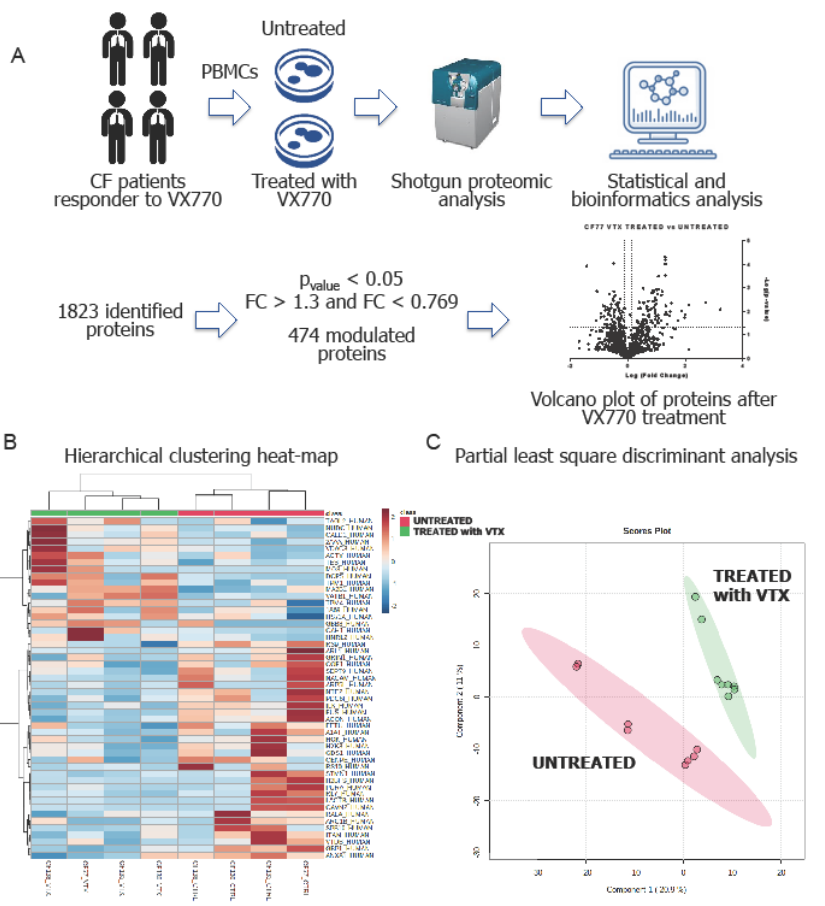
Figure 4. Shotgun proteomics of PBMCs treated with VX770 and untreated. ( A ) Modulated proteins were then elaborated with bioinformatics to identify biological mechanisms associated to CFTR restoration. A representative Volcano plot of four is shown. Each Volcano plot is in Supplementary Materials (Supplementary Materials Figure S1); ( B ) Clustering heat-map and ( C ) partial least square discriminant analysis (PLS-DA) of PBMCs treated with VX770 (green) and untreated (red). The heat-map was created using average proteomic values for each analyzed sample, while for the PLS-DA, technical replicates were also used. The statistical analysis based on the protein abundances reported the presence of a total of 474 modulated proteins associated to the restored CFTR activity (Supplementary Materials Table S2: Identified proteins). Multivariate analysis performed on the relative abundances of PBMCs proteins clearly showed a proteomic signature associated with the restoration of CFTR activity. The hierarchical clustering heat-map reported that VX770-treated cells (green) are well separated from untreated ones (red). The partial least square discriminant analysis confirmed the presence of structured proteomic information related to the CFTR rescue (Figure